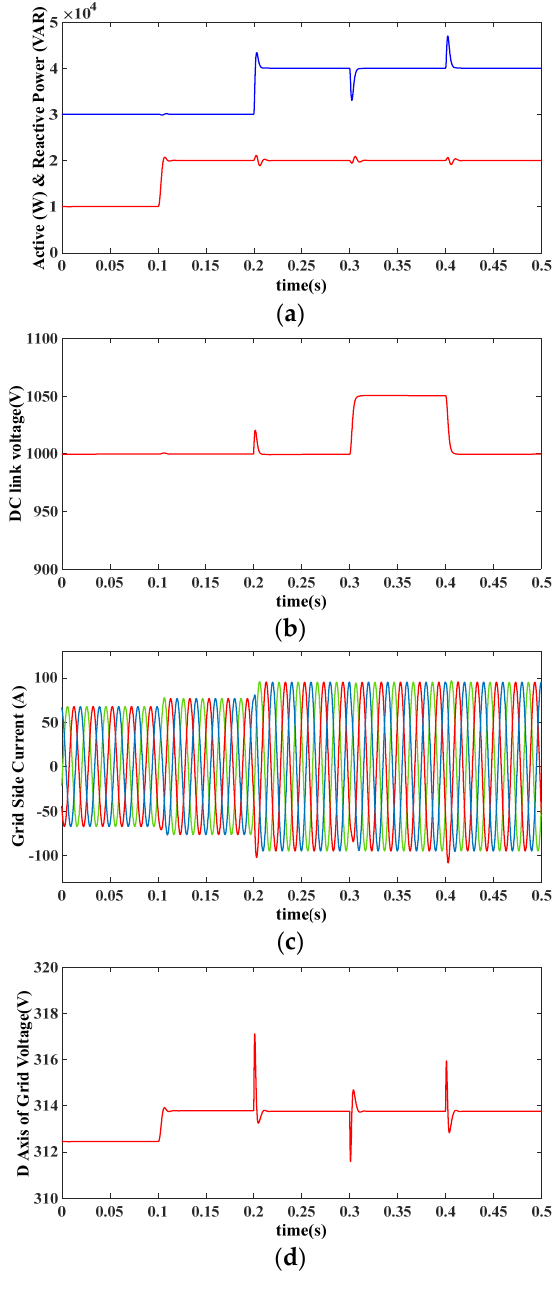
Figure 9. Response of the simulated system with L s = 0.4 mH; ( a ) the active and the reactive powers, ( b ) the DC-link voltage, ( c ) grid-side currents, and ( d ) PCC voltage magnitude.